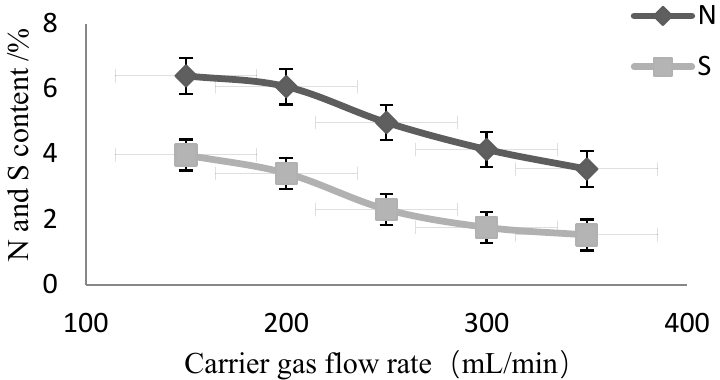
Figure 3. Effect of Carrier gas flow rate on N and S content. (n = 6) Herein, the CRM of nori (GBW10023) was measured by the TCD using different gas flow rates. Other experimental conditions were performed as per Table 1 .